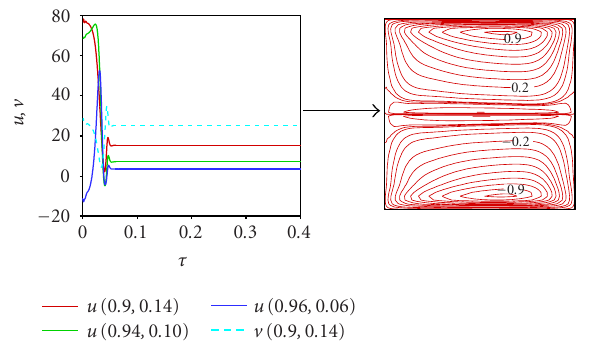
Figure 13: Evolution of solution a to solution c at L 2 = 50 labeled in Figure 2a ( σ = 0 . 02, Pr = 0 . 7, Dk = 300, and L 1 =